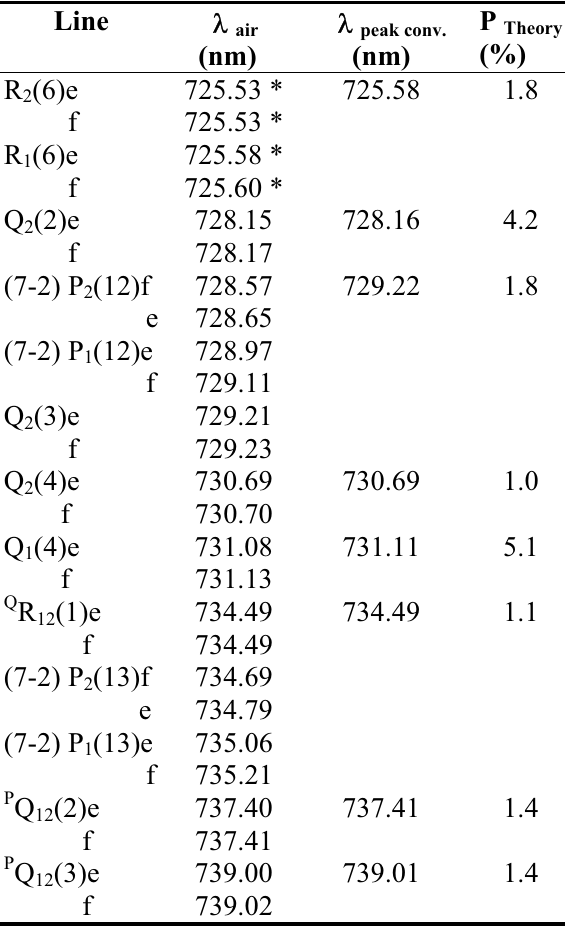
Table 2. OH(8–3) background features and unthermalised OH emissions. A theoretical spectrum (LWR, 214K) has been con- volved with the instrument function and the peak wavelength ( λ peakconv . ) and peak intensity (P theory ) relative to the P 1 (3) emis- sion is listed for the thermalised components. Blended lines are indicated by a symbol ( ∗